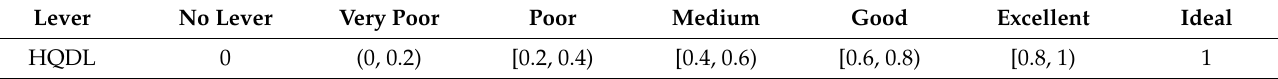
Table 3. The grading standard of